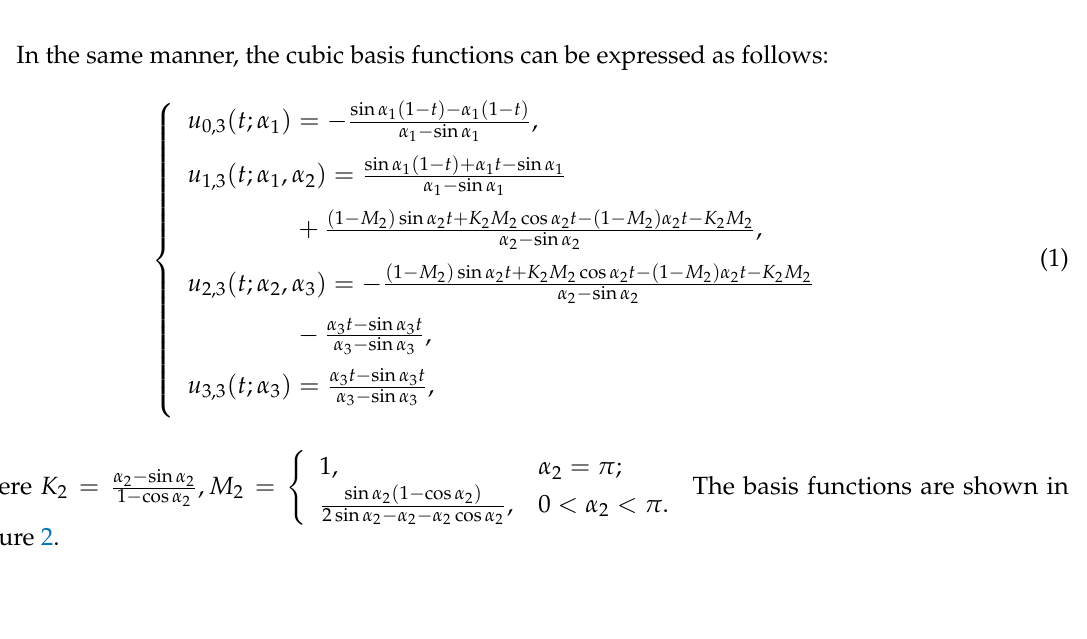
, α 2 = π ; ( b ) α 1 = π 8 8